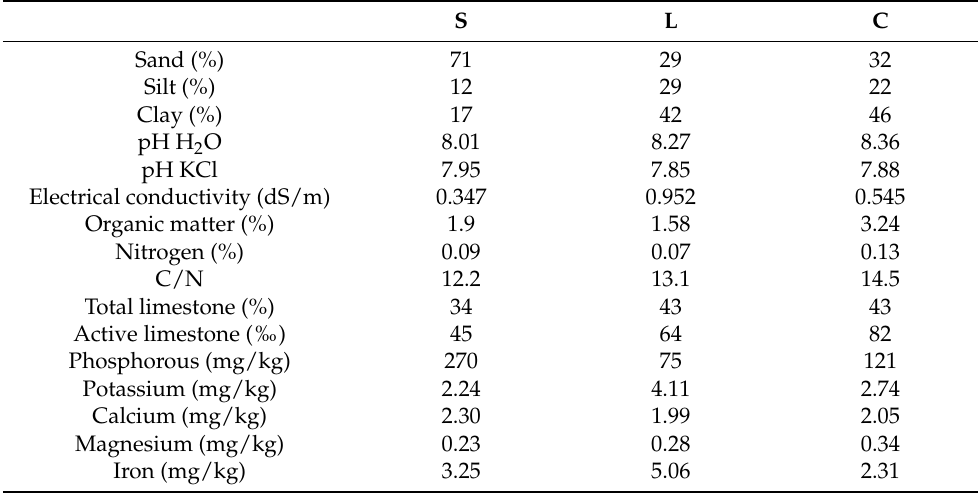
Table 1. Physico-chemical parameters of the studied soils: sandy loam (S), clay loam (L), and clay (C). S